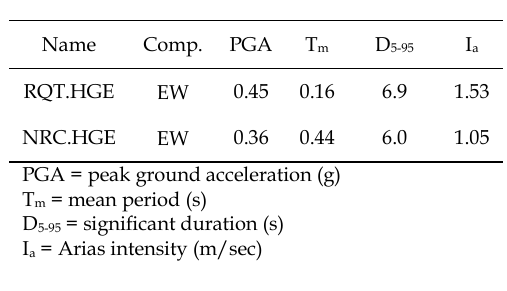
Table 1: Selected ground motion records